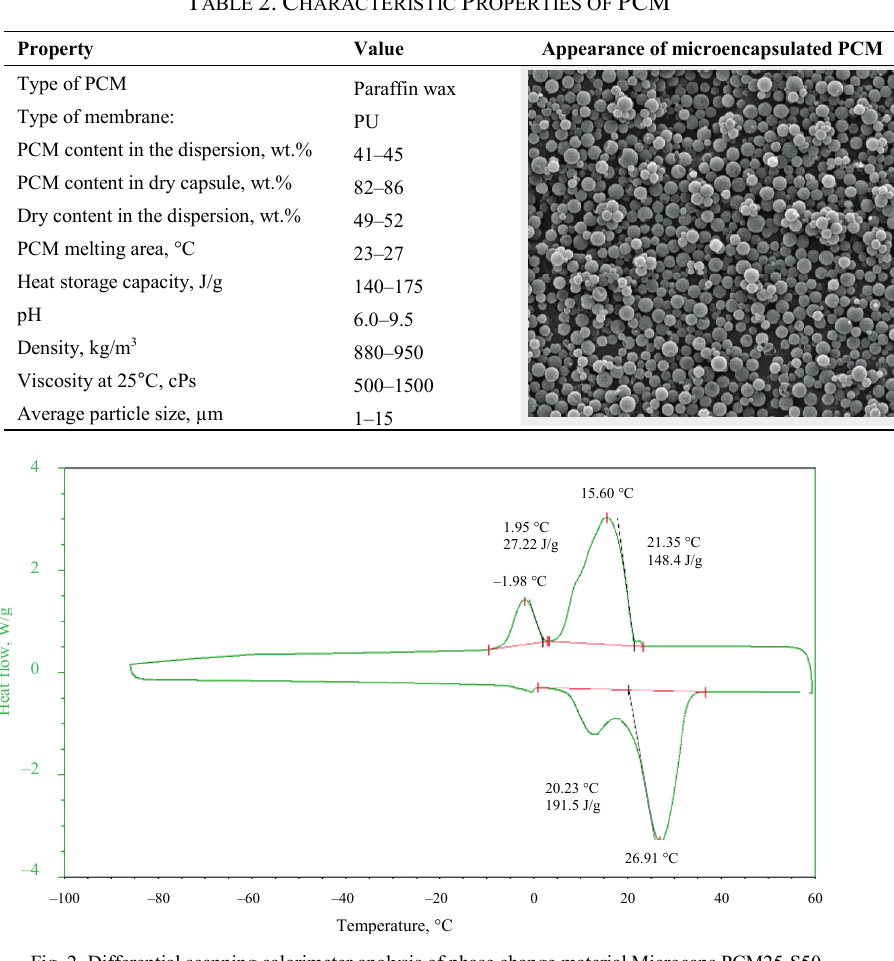
Fig. 2. Differential scanning calorimeter analysis of phase change material Microcaps PCM25-S50. Two enthalpy ranges were observed. During the cooling process, the water freezing